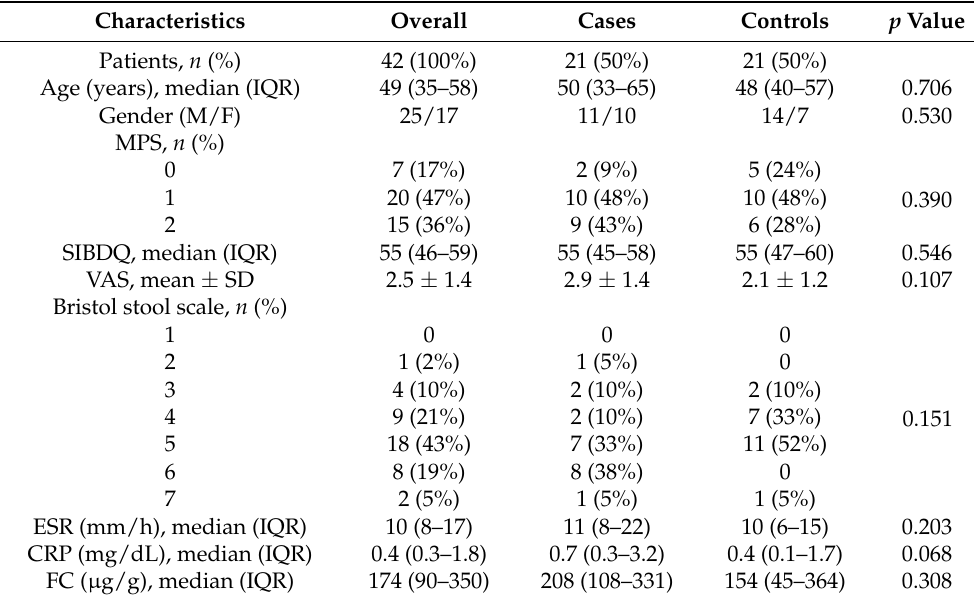
Table 1. Baseline characteristics of the overall study population and according to treatment regimen.